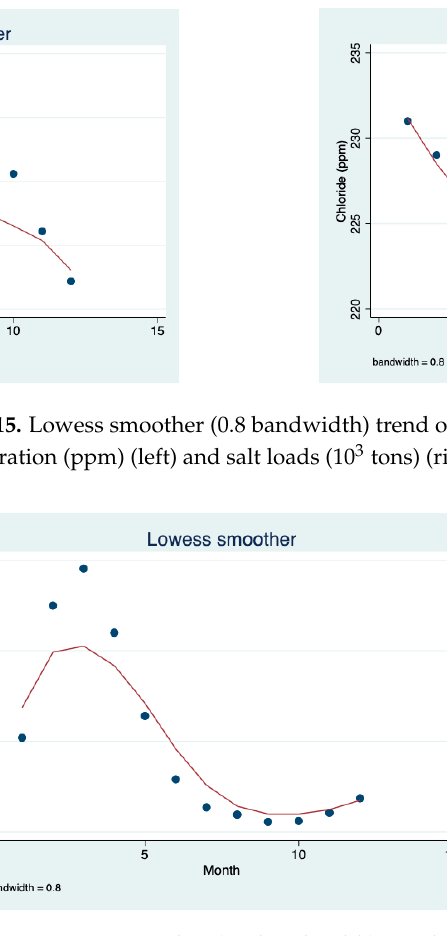
Figure 16. Lowess smoother (0.8 bandwidth) trend of changes plot of monthly changes of nitrate concentrations (ppm scale range: 0.0–0.3)